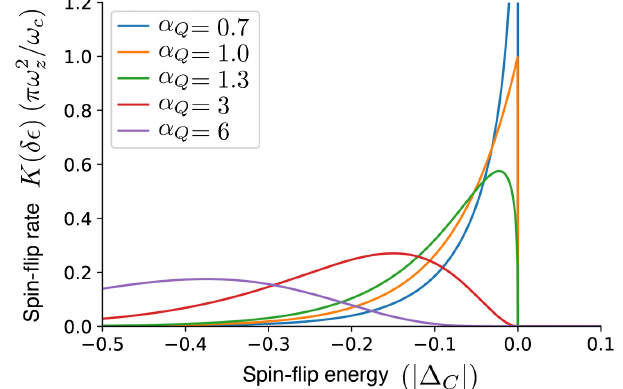
FIG. 16. The spin-flip rate versus energy for an Ohmic quantum bath for various bath coupling strengths α . Three regimes of Q < 1 dynamics are apparent. The spin-flip rate diverges for α Q near δϵ ¼ 0 , giving rise to dynamics that perform the smallest ≃ 1 , the spin-flip rate energy-lowering spin flips possible. For α Q is roughly flat for negative δϵ , matching 0TMH dynamics. > 1 , the spin-flip rate rises sharply as δϵ Finally, for α Q approaches zero. This spin-flip rate describes dynamics akin to SD, in which the most energy-lowering spin flip has the highest spin-flip